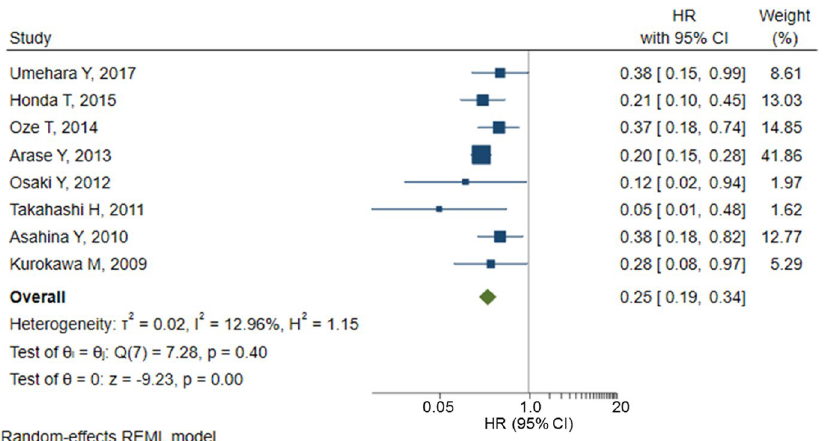
Figure 2. Forrest plot of the pooled estimate of the hazard ratio of HCC incidence adjusted for potential covariates in patients treated with antiviral therapy (SVR vs. non-SVR) in 8 studies. HCC hepatocellular carcinoma, SVR sustained virologic response, HR hazard ratio, CI confidence